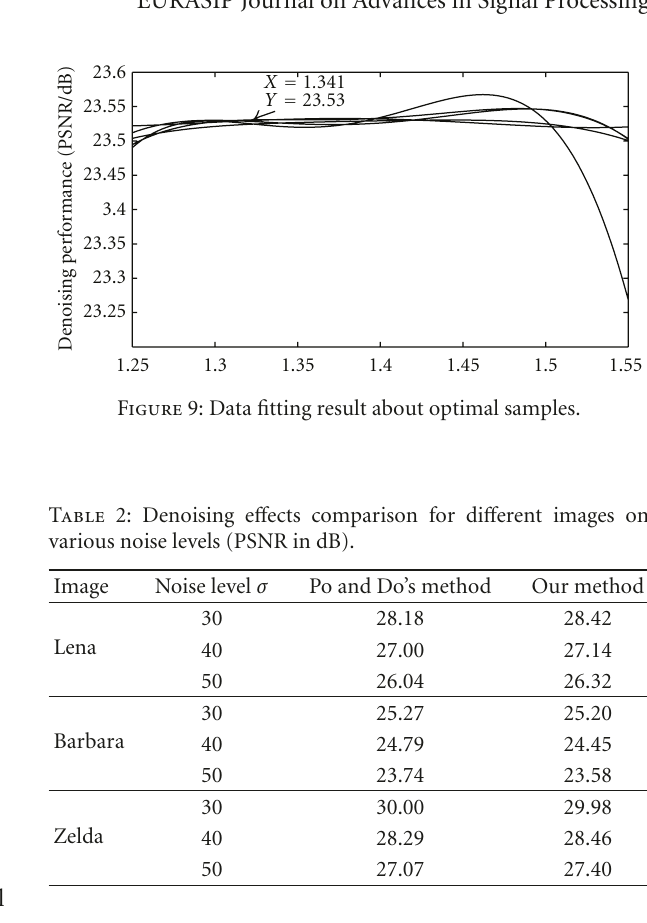
used in the contourlet HMT model and on the experimental platform presented by Po and Do [12], the image denoising performance in terms of the PSNR is maximum and equals 23.53 dB.